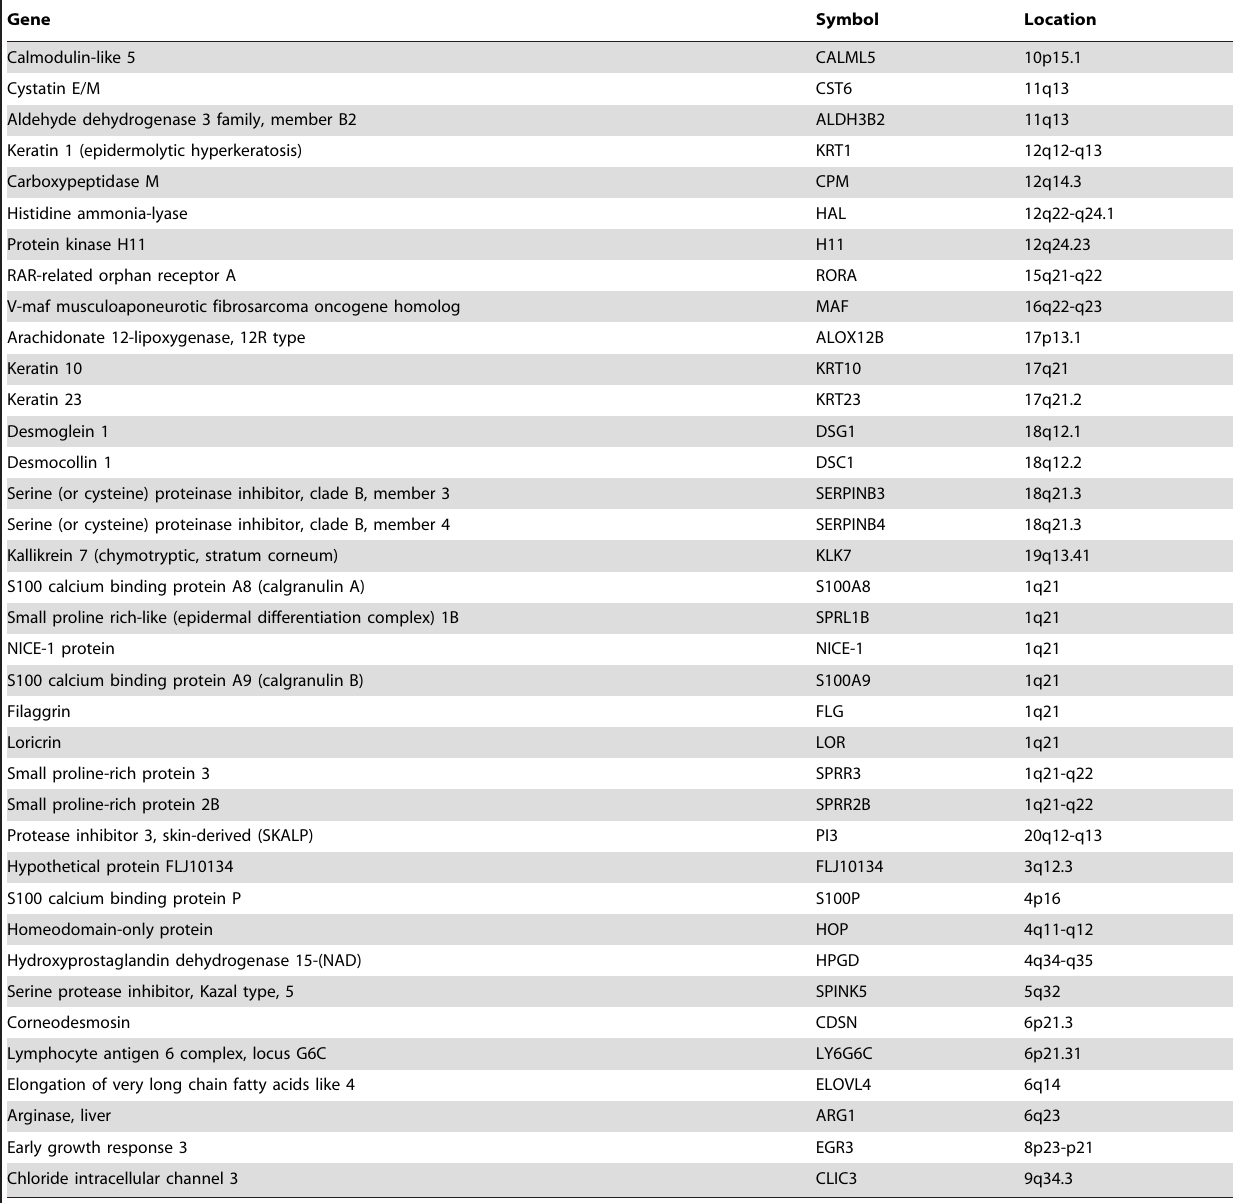
Table 2. Genes forming the epithelial barrier (expression cluster